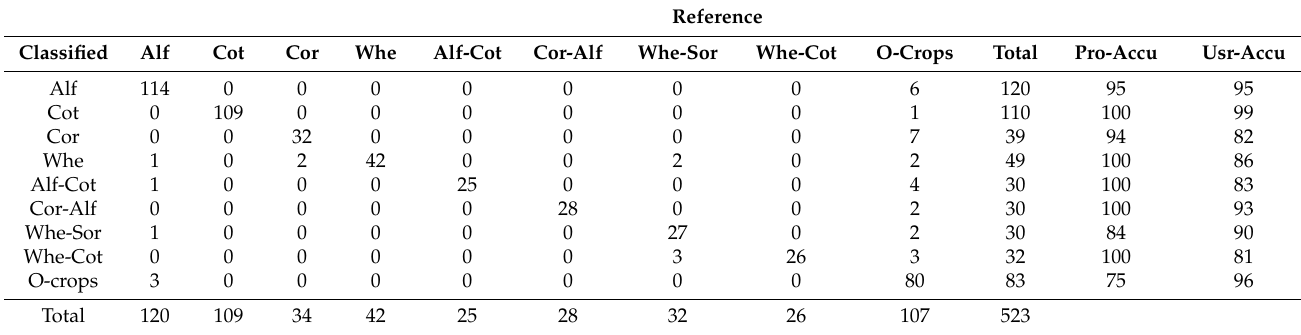
Table 1. Image classification accuracy using 2001 crop type map as an example (Alf = Alfalfa; Cot = Cotton; Cor = Corn; Whe = Wheat; Sor = Sorghum; Pro-Accu = Producer’s Accuracy; Usr-Accu = User’s Accuracy).